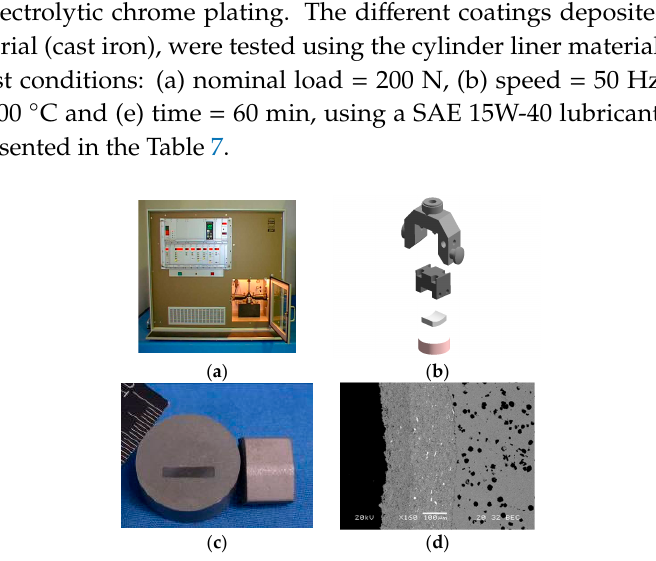
Figure 6. ( a ) SRV machine, ( b ) Cylinder-on-disc test configuration, ( c ) testing specimens and ( d ) nano-HVOF coating micrograph.